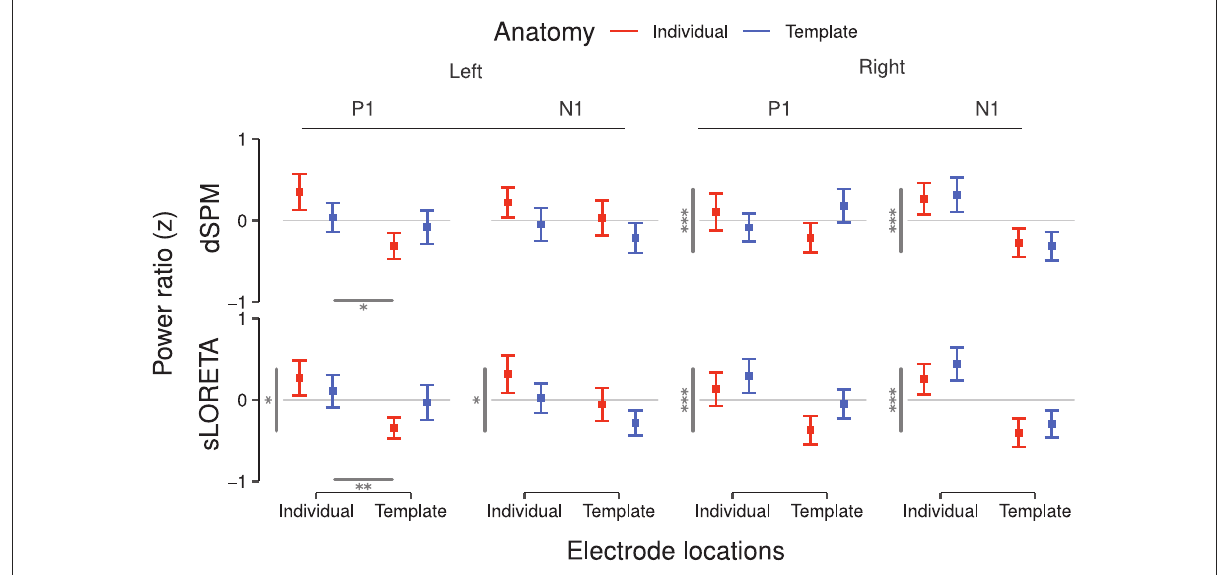
FIGURE6 ROI power ratios for P1 and N1 components inferred via dSPM (top) and sLORETA (bottom) for the left and right hemisphere. Higher ratios are interpreted as indication for lower spatial leakage of inferred PAC source activity. Values correspond to the average over subjects after z-scoring per hemisphere, inverse solution, and subject. Error bars denote the SEM. Statistically significant differences between main effects are reported as gray bars—horizontal bars for electrode positions and vertical bars for brain anatomies—and from one to three asterisks indicating the